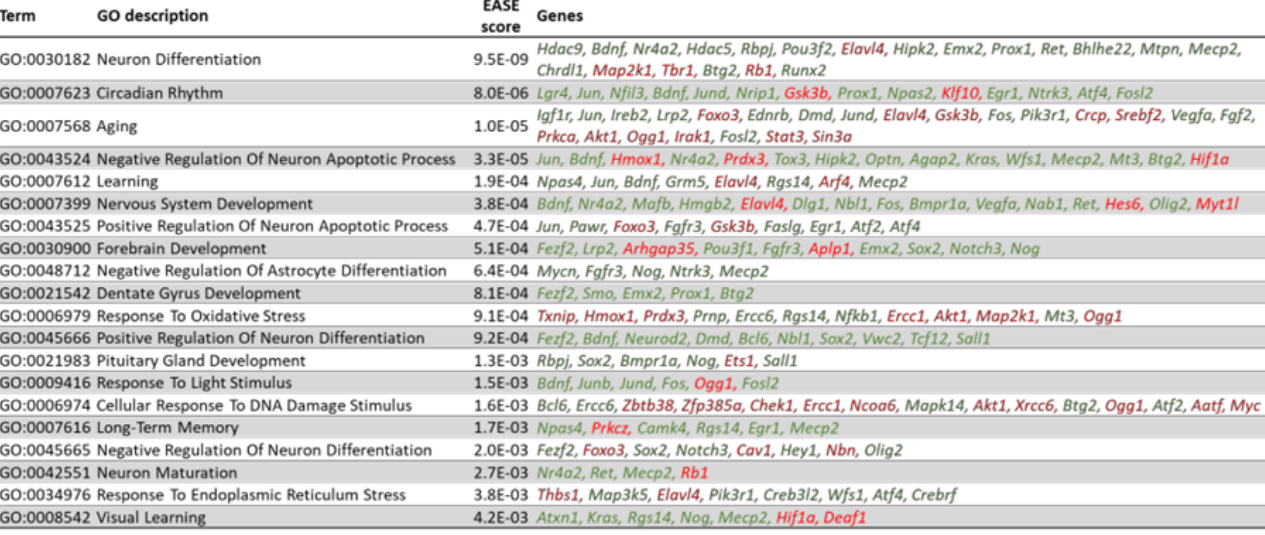
Figure 17. Upstream regulators associated with differential gene expression observed upon knockdown of Arc. Activation z-score indicates the predicted activity of upstream regulators by